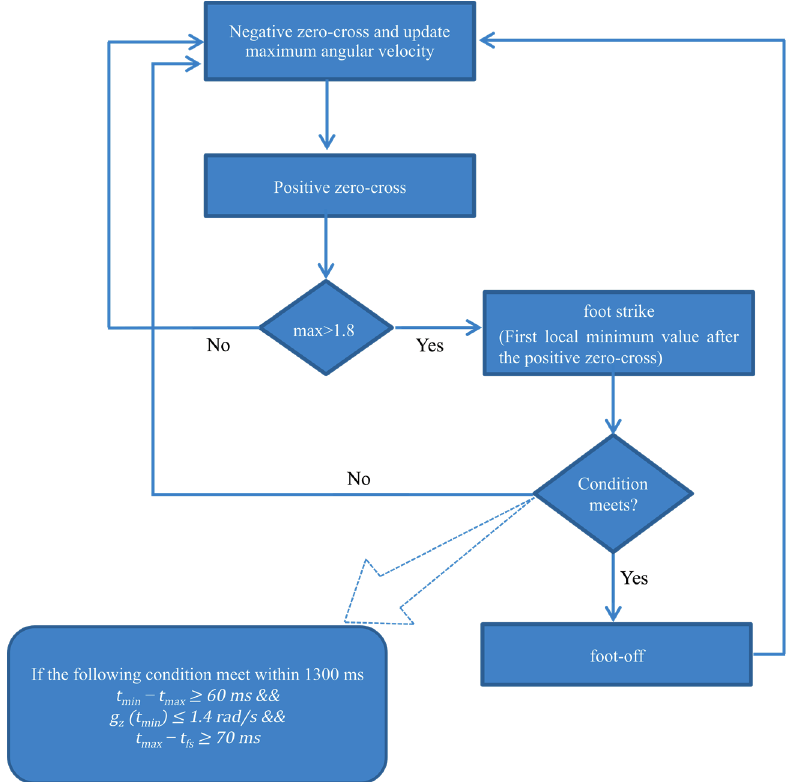
Figure 2. Signal segmentation algorithm flow diagram.